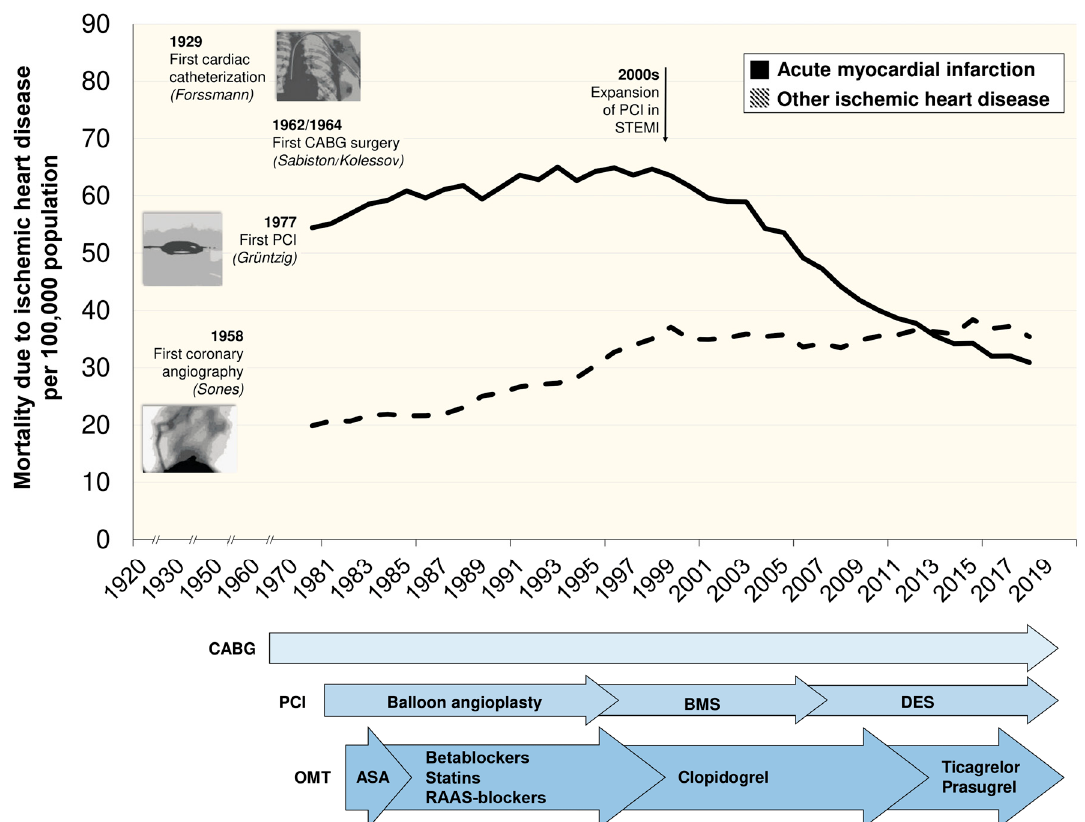
Figure 1. Time trends in mortality attributable to acute coronary syndrome (classified as acute myocardial infarction) and chronic coronary syndrome (classified as other ischemic heart disease) between 1980 and 2018, and main breakthroughs and research data in coronary revascularization and medical therapy during the last century. Data provided by the National Statistics Institute (I.N.E.) in Spain [56]. After the expansion of PCI in STEMI, a marked reduction in mortality was noted in acute myocardial infarction patients. This trend was not evident in patients with chronic coronary syndrome despite the widespread availability and use of CABG and PCI. Different groups of pharmacological therapies with beneficial effects on cardiovascular mortality have been incorporated into clinical practice during recent decades, and thus the “optimal medical treatment” has been improving over time. Abbreviations: ASA, Acetylsalicylic acid; BMS, Bare-metal stent; CABG, Coronary artery bypass grafting; DES, Drug-eluting stent; PCI, Percutaneous coronary intervention; RAAS,